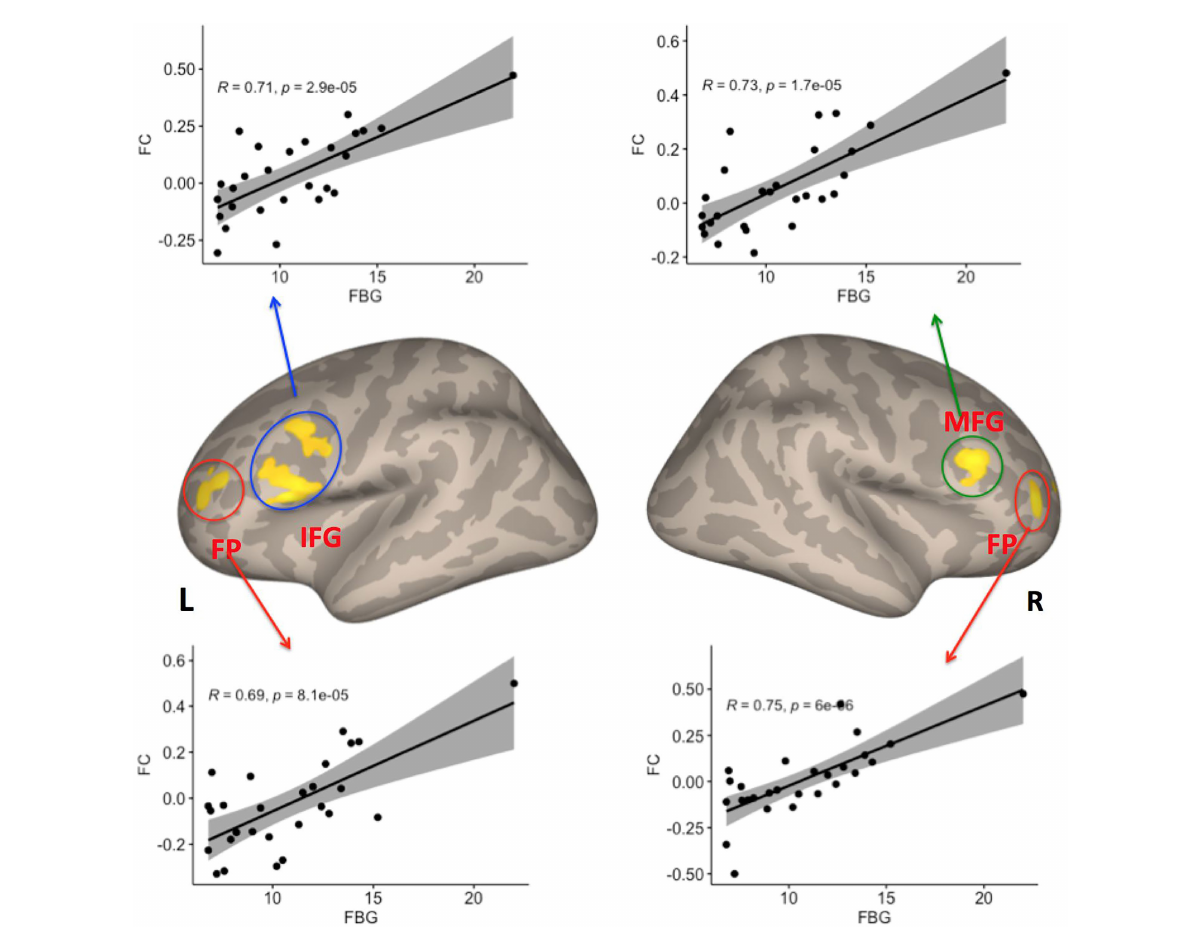
FIGURE 3 Four clusters showed significant correlations between FC with the right caudate and fasting blood glucose (FBG) variables among patients with T2DM ( p < 0.05, FDR–corrected). IFG, inferior frontal gyrus; FP, frontal pole; MFG, middle frontal gyrus; FDR, false discovery rate, L Left; R Right.